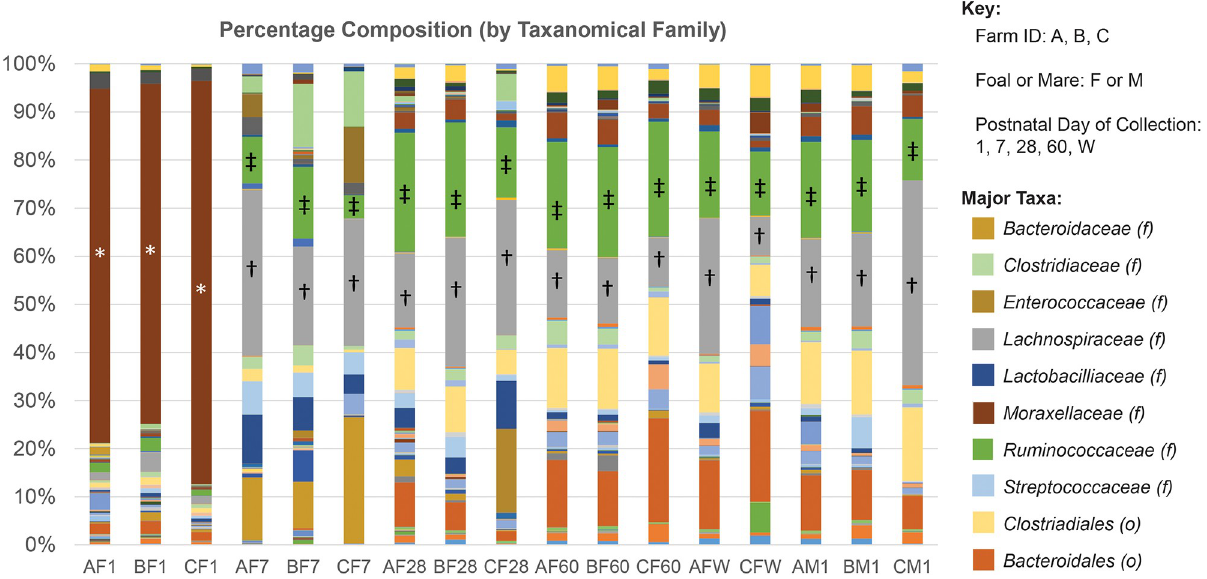
Fig 4. QIIME’s taxonomical plots can be used to compare and contrast across farm, age, and mare or foal status. From the preliminary sequence data, certain trends can be seen. For example, in the first day of life fecal samples contain higher levels of bacteria from the Moraxellaceae family ( � ), commonly found in soil. By Day 7, there is a great deal of variation. Two common populations in foals from Day 7 until weaning, and in mares, include bacteria from families Lachnospiraceae (†) and Ruminococcaceae (‡) necessary for breakdown of complex carbohydrates like with grass